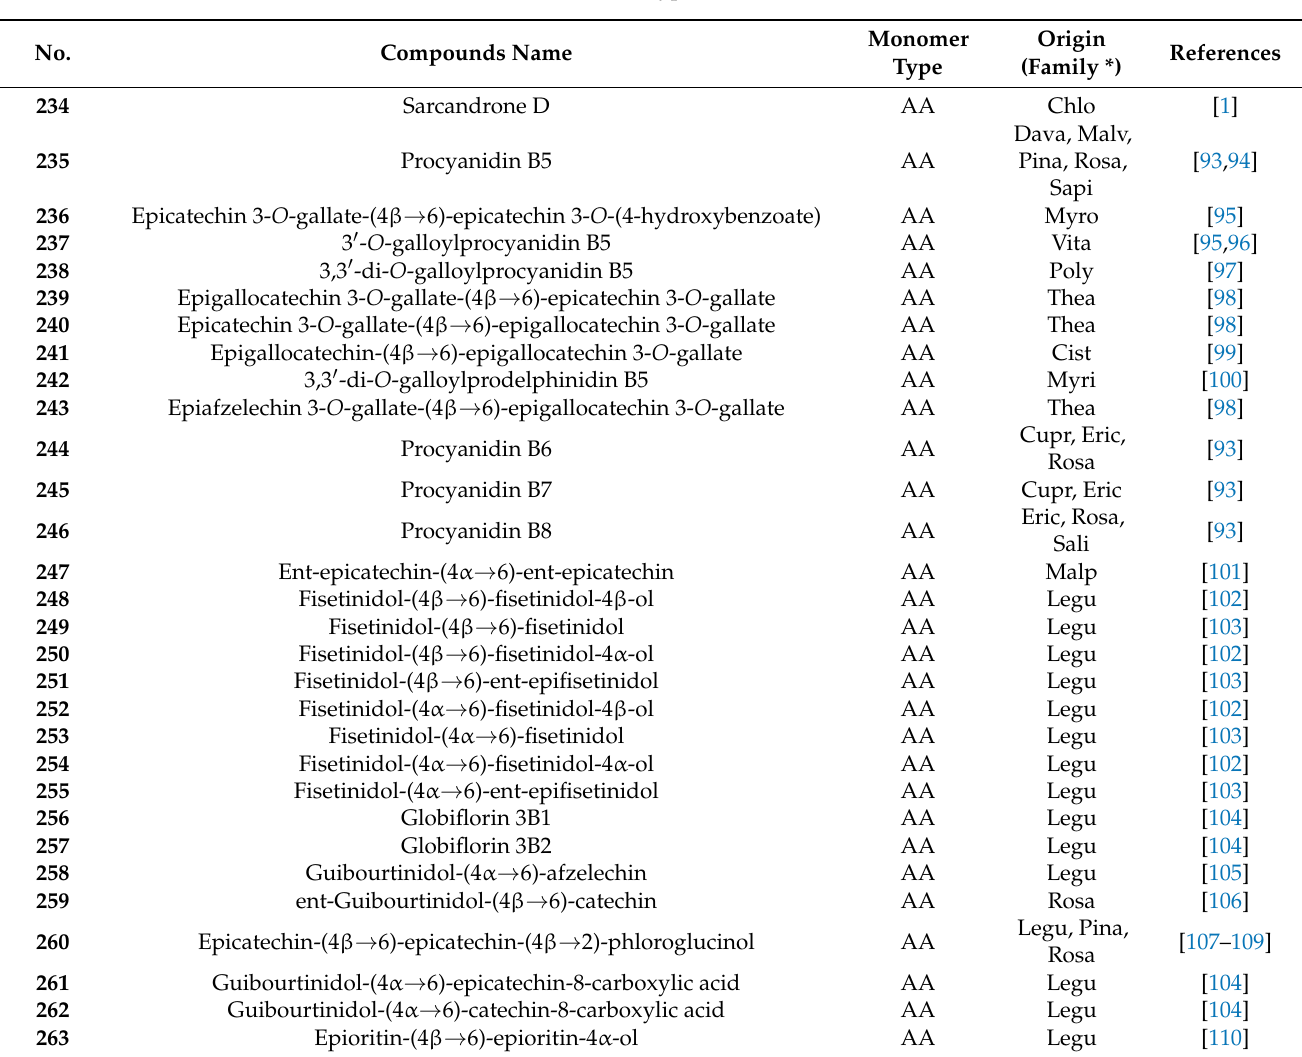
Table 5. The 4-6 (cid:48)(cid:48) subtype of